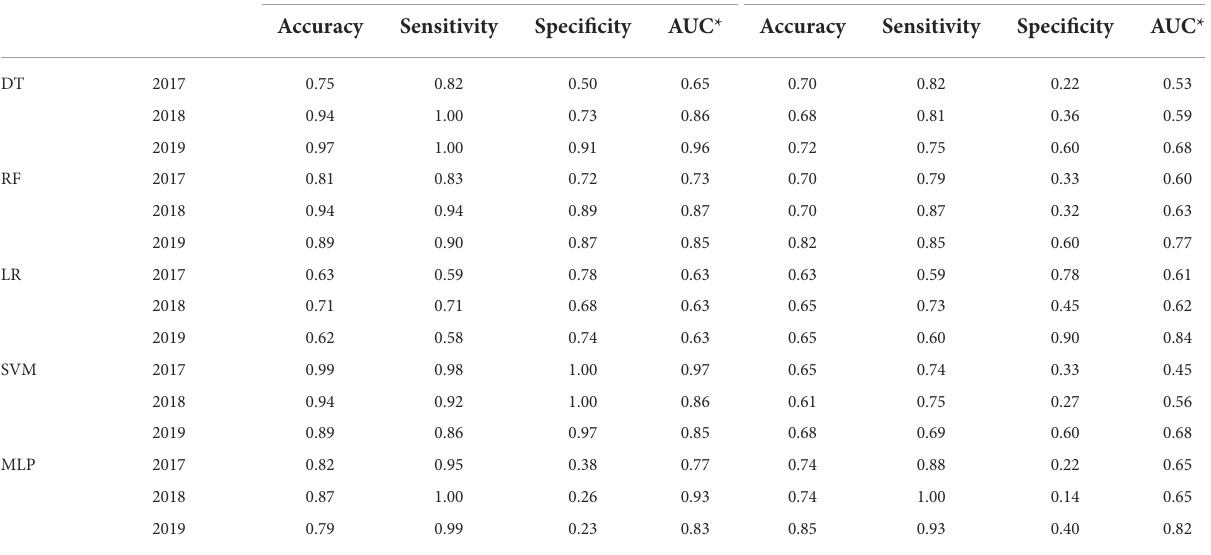
TABLE 3 Results for the ML models.